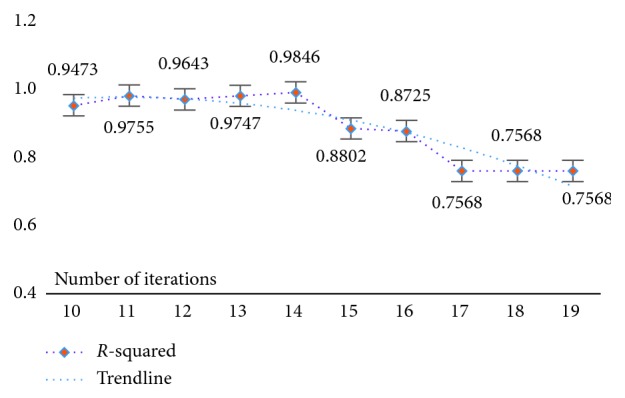
RBuild: R-squared.